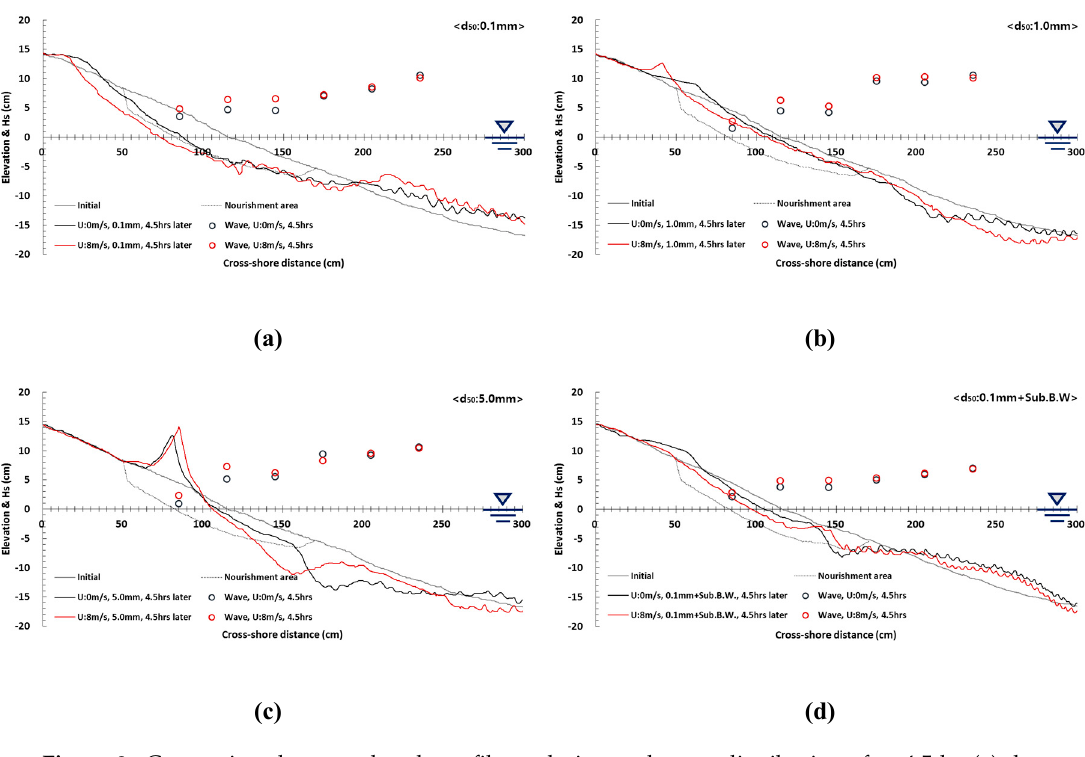
Figure 8. Comparison between beach profile evolution and wave distribution after 4.5 h. ( a ) d 50 , 0.1 mm, ( b ) d 50 , 1 mm, ( c ) d 50 , 5 mm, ( d ) d 50 , 0.1 mm + Sub. B.W.